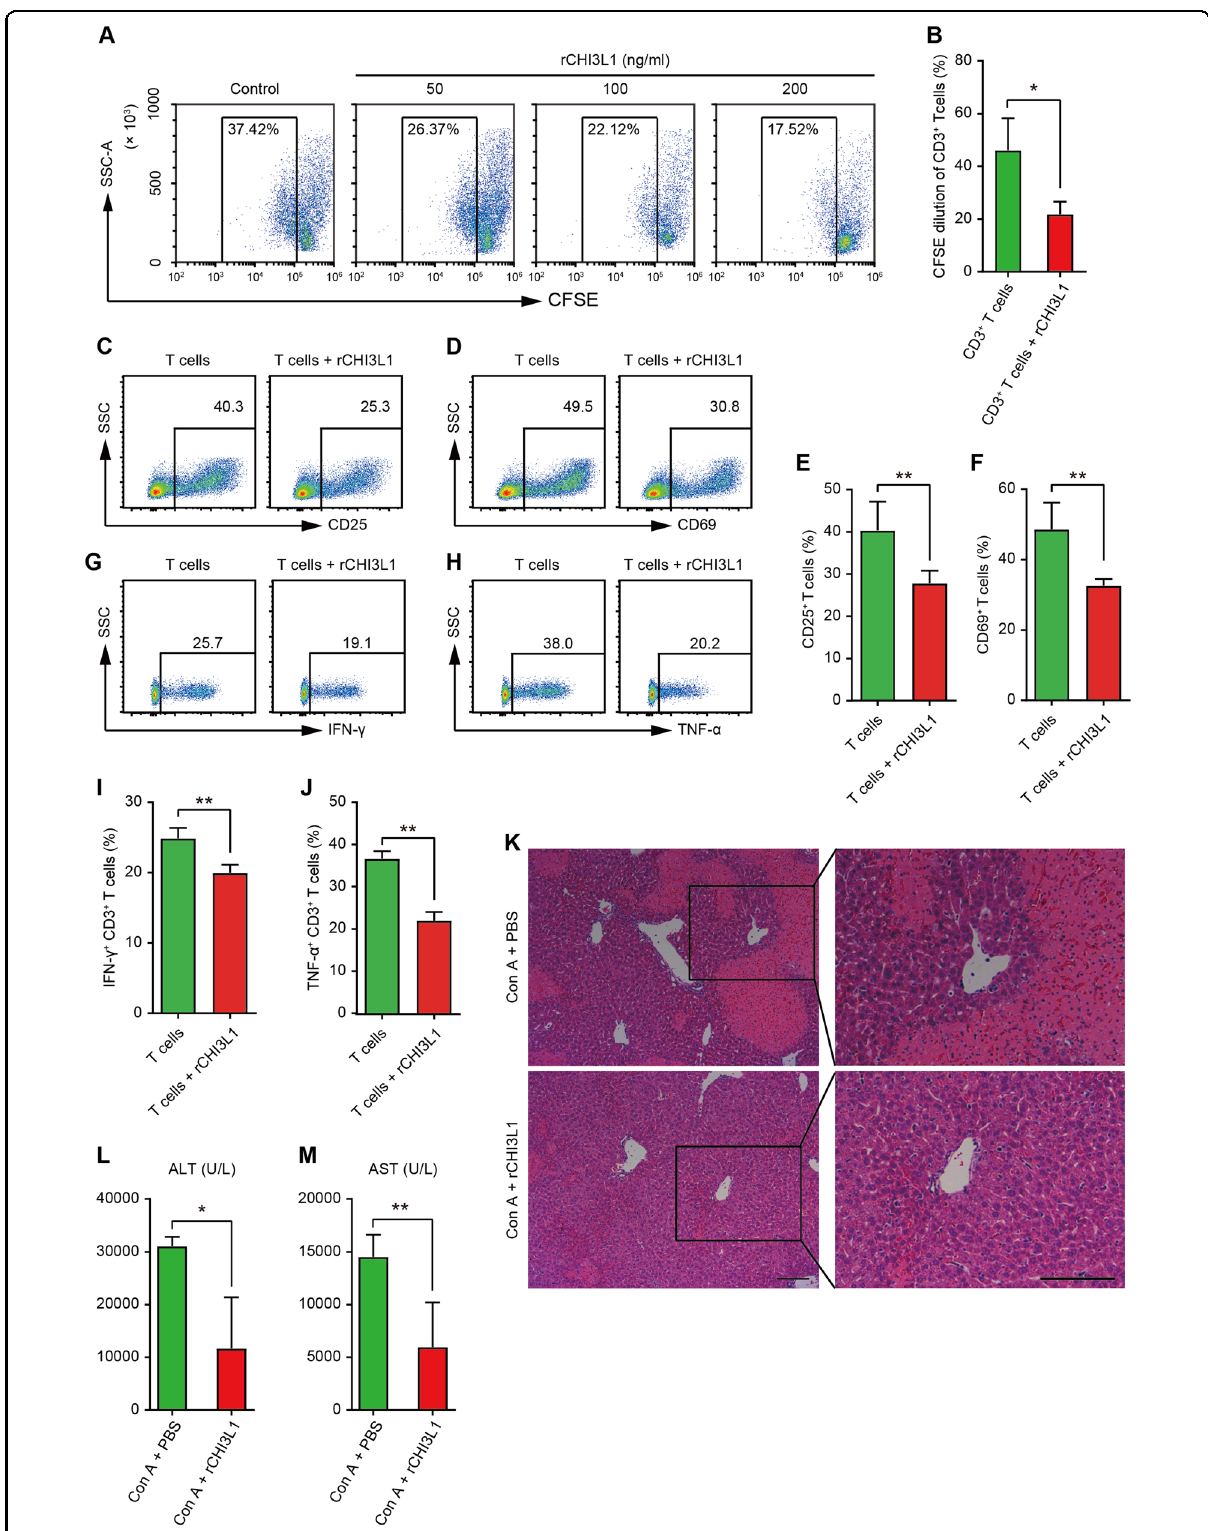
Fig. 5 (See legend on next